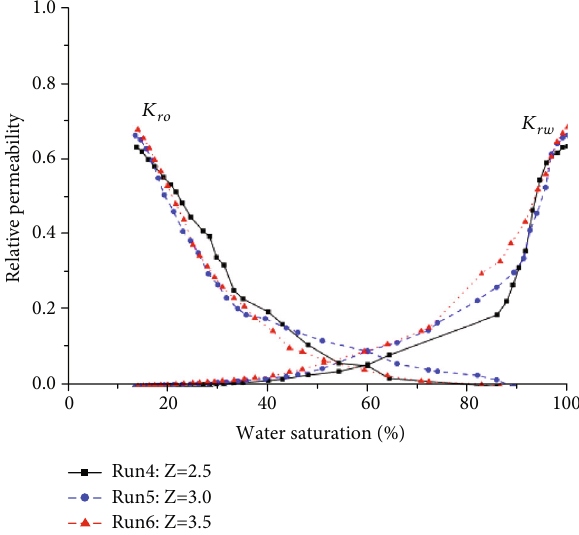
Figure 5: E ff ect of pore radius on relative permeability.